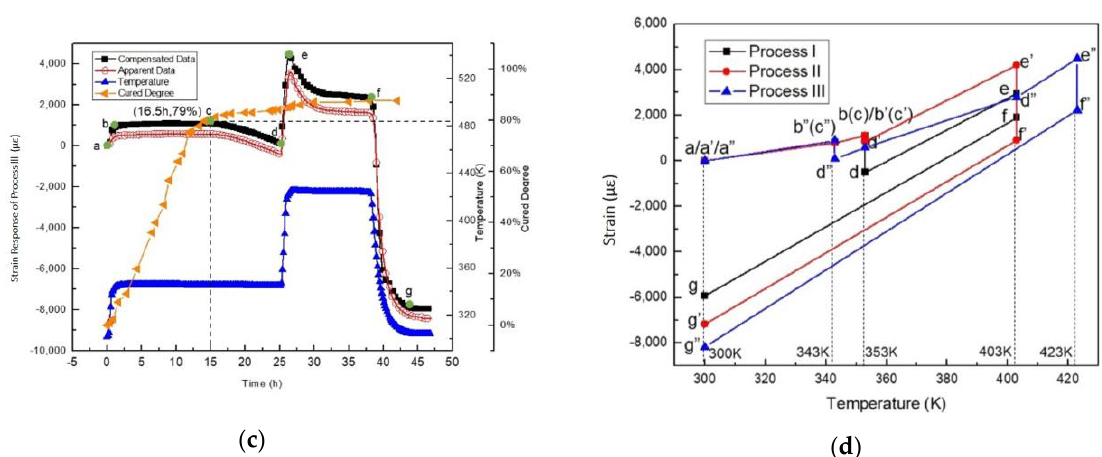
Figure 6. Curing degrees and comparison of real-time strain response of epoxy curing in different processes, apparent data and compensated data of ( a ) Process I, ( b ) Process II, and ( c ) Process III, and ( d ) strain responses (compensated data) comparison of three curing processes. Table 1. Cured percentage and Residual strains of epoxy resin curing with different